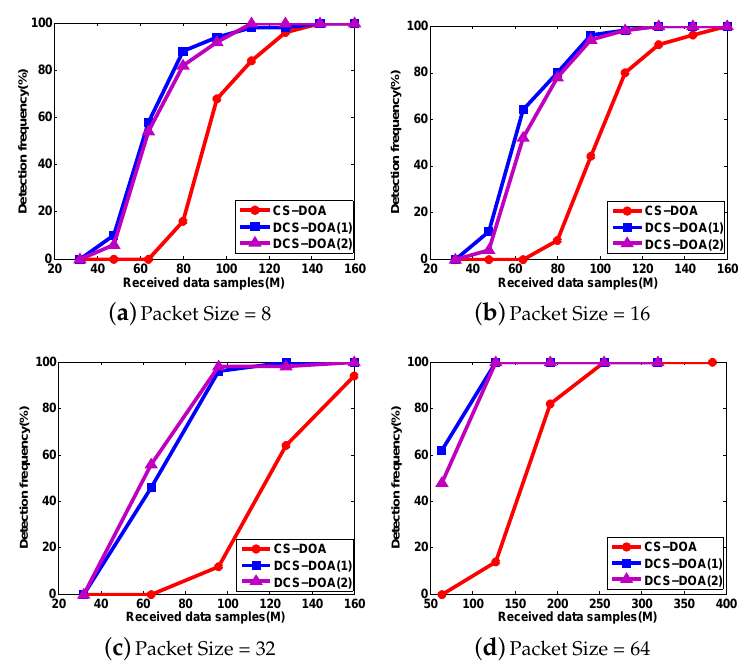
Figure 13. The comparison of detection frequency between CS-DOA and DCS-DOA under different packet sizes.